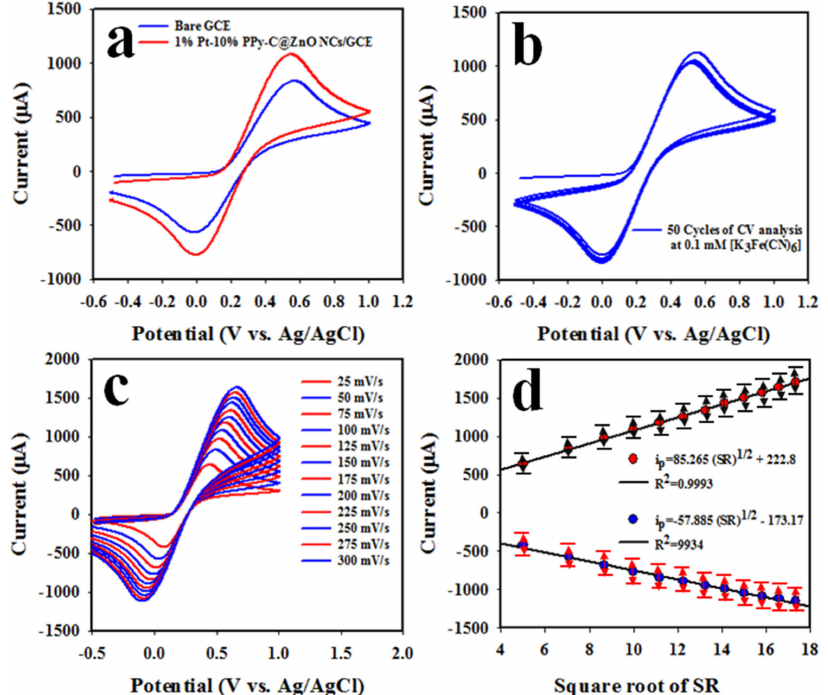
Figure 7. The electrochemical characterization of Pt − NPs- embedded PPy − CB@ZnO NCs/GCE by cyclic voltammetry; ( a ) The comparison of coated and bare − GCE in analysis of 0.1 mM K 4 [Fe(CN) 6 ], ( b ) stability of coated GCE, ( c ) scan rate at 25~300 mV/s, and ( d ) current versus square root of